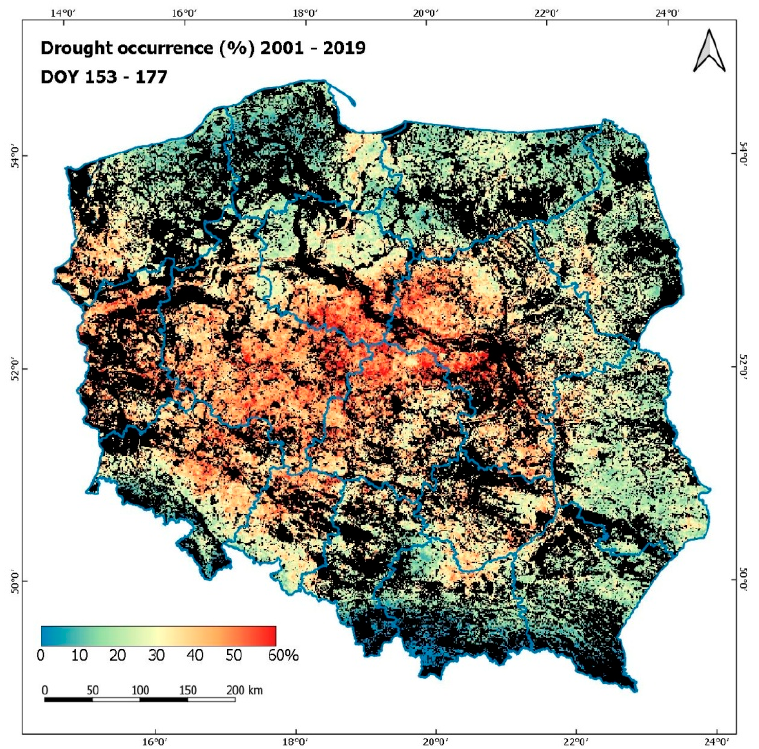
Figure 27. Percentage of drought occurrence in the 2001–2019 period (June 03–June 26).